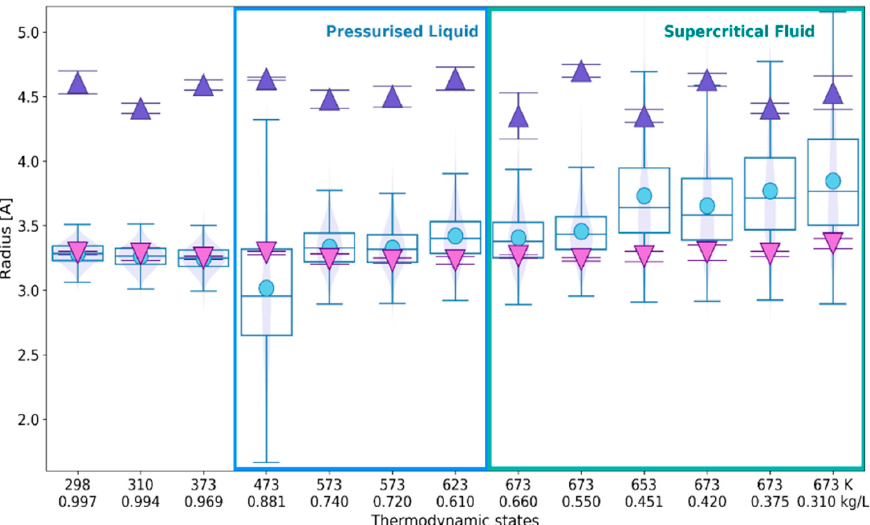
Figure 8. Face-weighted radius R w (circles in box-and-whiskers-violin plot) versus RDF-based assessment of spatial extent of the • OH aq solvation shell: (down triangles) 1st maximum position of O r –O w RDF, (up triangles) position of the 1st minimum. The thermodynamic states are defined in Table 1. The values of the probability density distribution function are shown by the violin plots.